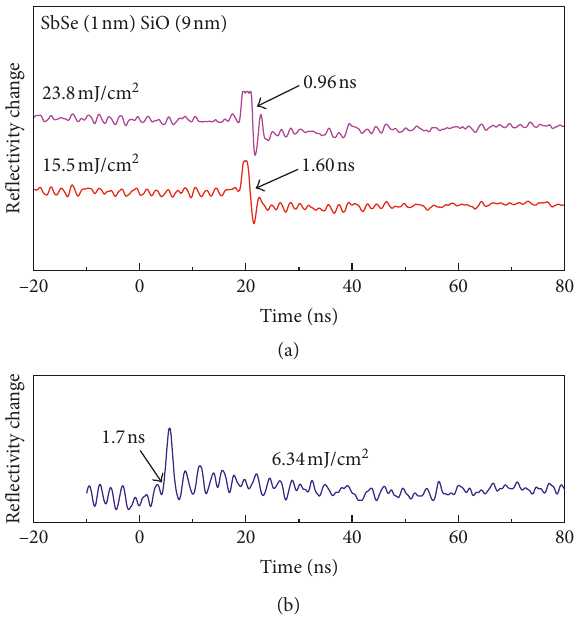
Figure 6: Reversible reflectivity evolution of SbSe (1nm) SiO (9nm) thin film: (a) amorphization and (b)